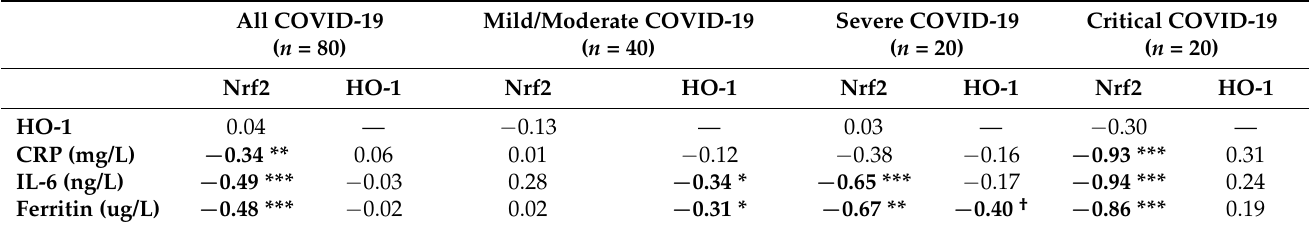
Table 4. Intercorrelations of Nrf2 and HO-1 with CRP, IL-6 and ferritin.